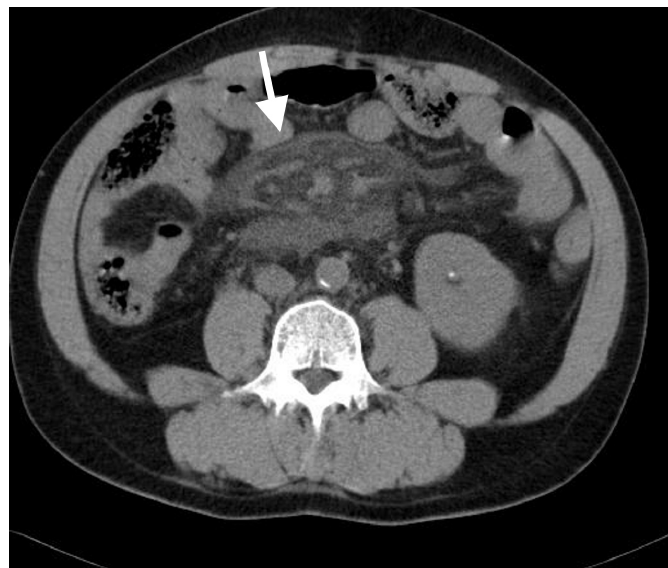
Image 2 . Computed tomography showing “misty mesenteric” vessels surrounded by fat stranding